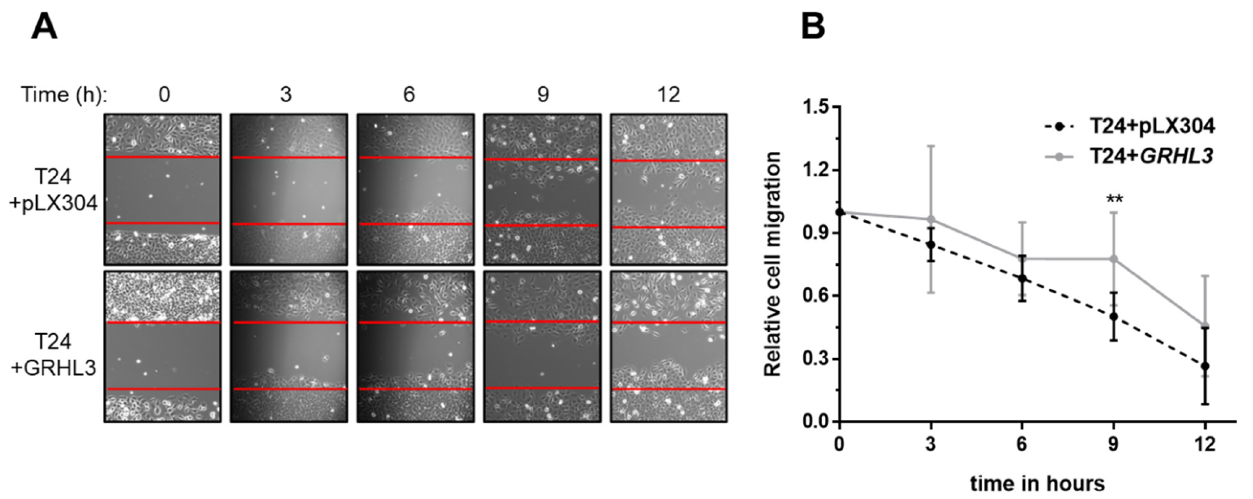
Figure 3. GRHL3 overexpression reduces migration in scratch wound assay. ( A ) Representative scratch wound experiment, displaying the original scratch wound gap in each picture by red lines during gap closure over 12 h. ( B ) Quantification of the “wound” closure shows that ectopic GRHL3-expressing T24 cells migrate significantly more slowly compared to empty vector controls (T24 + pLX304) at 6, 9 and 12 h ( p = 0.0013 at 9 h). Seven replicates were performed in this experiment. ** indicates p -value < 0.01.